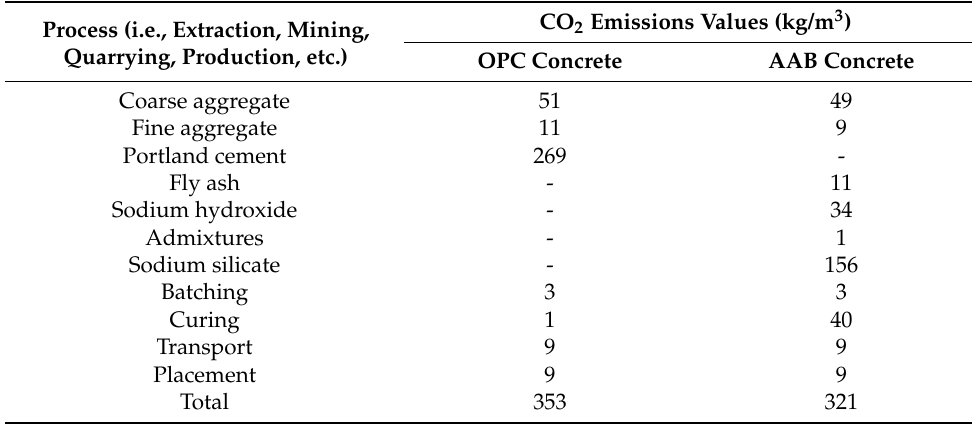
Figure 8. Life cycle stages for alkali-activated binder (geopolymer) concrete. Table 2. Comparison of CO 2 emissions between OPC and AAB concretes (per 1 m 3 ) [12]. Process (i.e., Extraction, Mining, Quarrying, Production,